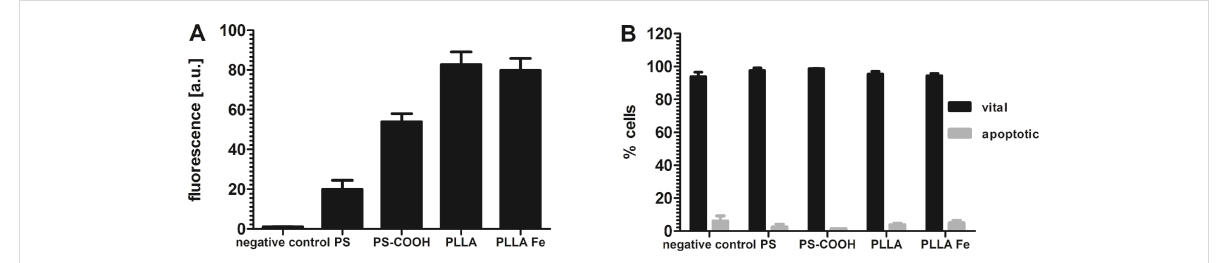
Figure 1: (A) Nanoparticle uptake after 24 h incubation of hMSCs with 300 µg/mL nanoparticles analyzed by flow cytometry. Fluorescence [a.u.] = median fluorescence intensity, arbitrary units. All cells with nanoparticles show a significantly higher fluorescence intensity compared to the negative control (three independent experiments, p < 0.05). (B) Cytotoxicity study of the nanoparticles after 24 h incubation with 300 µg/mL particles analyzed by 7-AAD staining and flow cytometry. Dead cells were not included in the analysis because they constituted less than 1%. The amount of apoptotic cells is given in Supporting Information File 1, Figure S1.